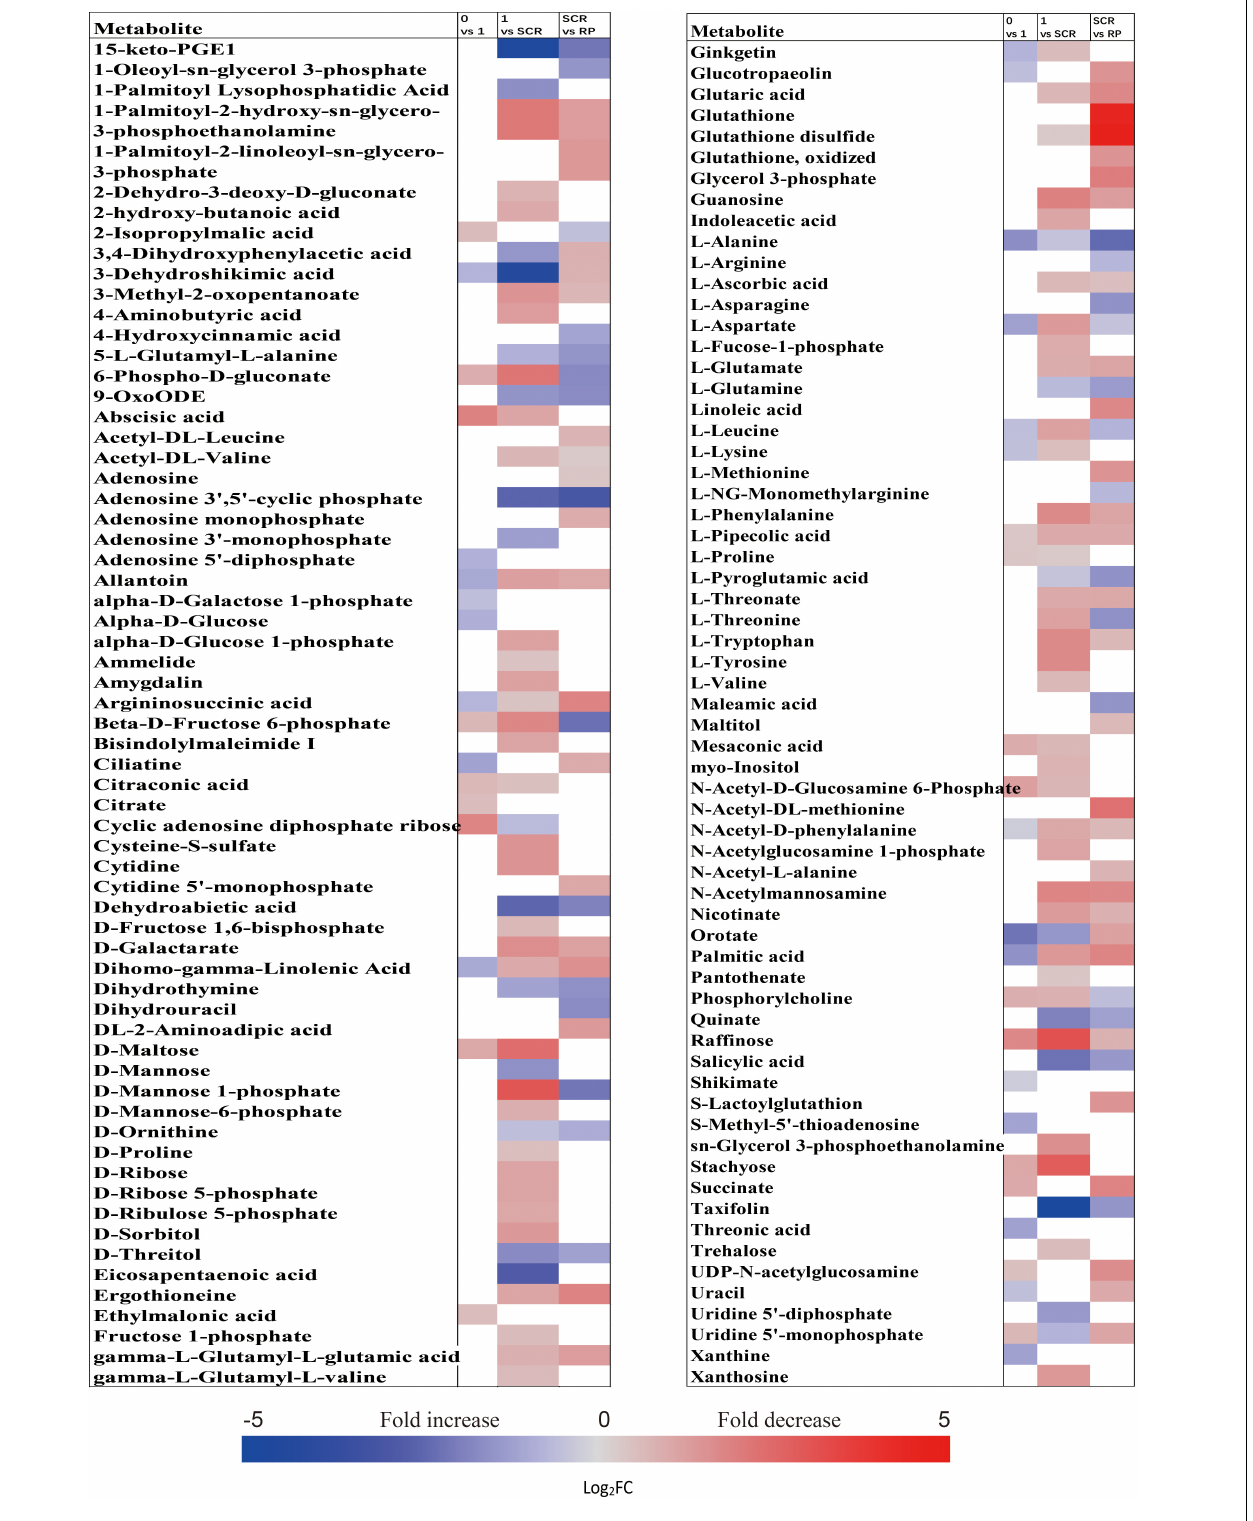
Frontiers in Plant Science |